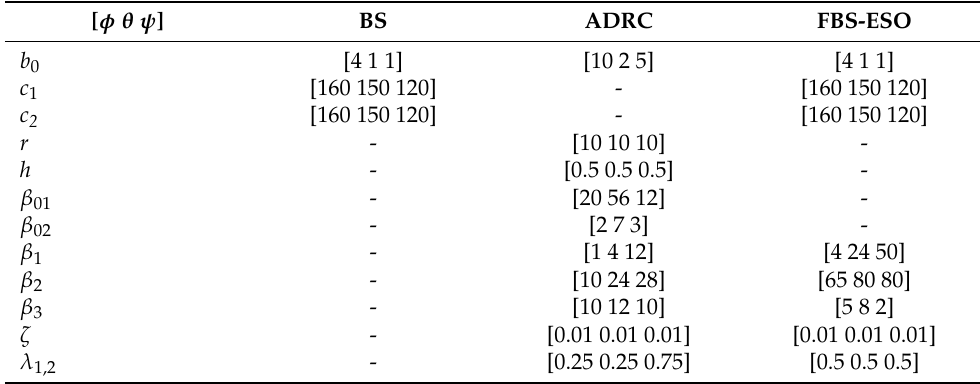
Table 5. Parameters of the